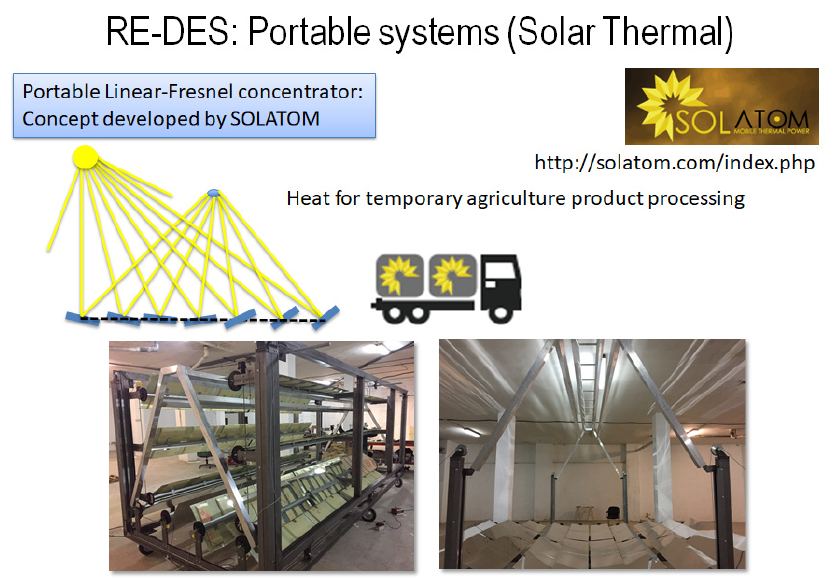
Figure 11. Concept of portable solar heat (courtesy of SOLATOM).